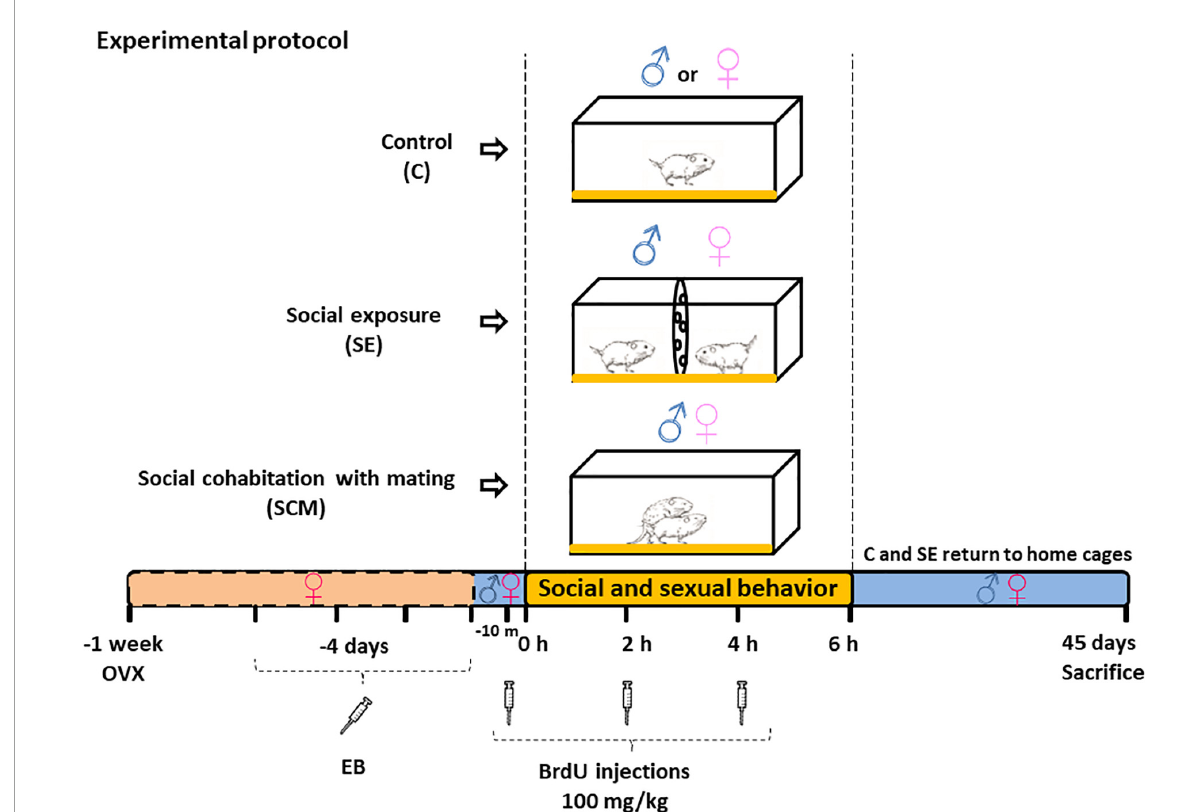
FIGURE1 Diagram of the experimental protocol experimental conditions for Control (C), social exposure to a conspecific of the opposite sex (SE) and social cohabitation with mating (SCM) animals. BrdU (5-bromo-2-deoxyuridine) was injected 10 min before the behavioral test and 2 and 4 h after the test. EB, estradiol benzoate; OVX, bilateral